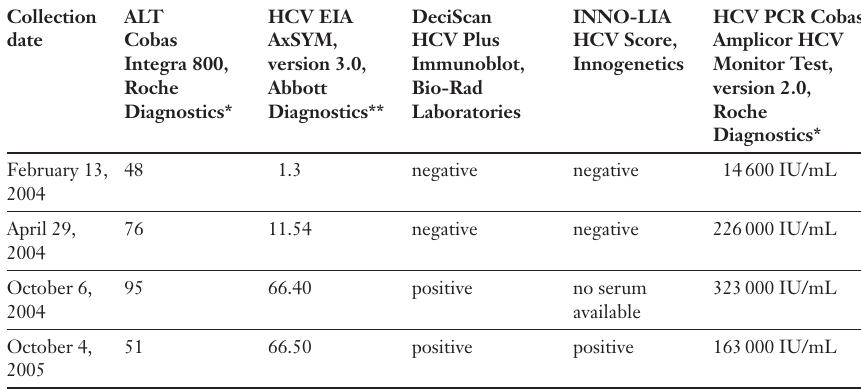
False negative immunoblot results as a potential cause of missing a hepatitis C virus infection in an intravenous drug